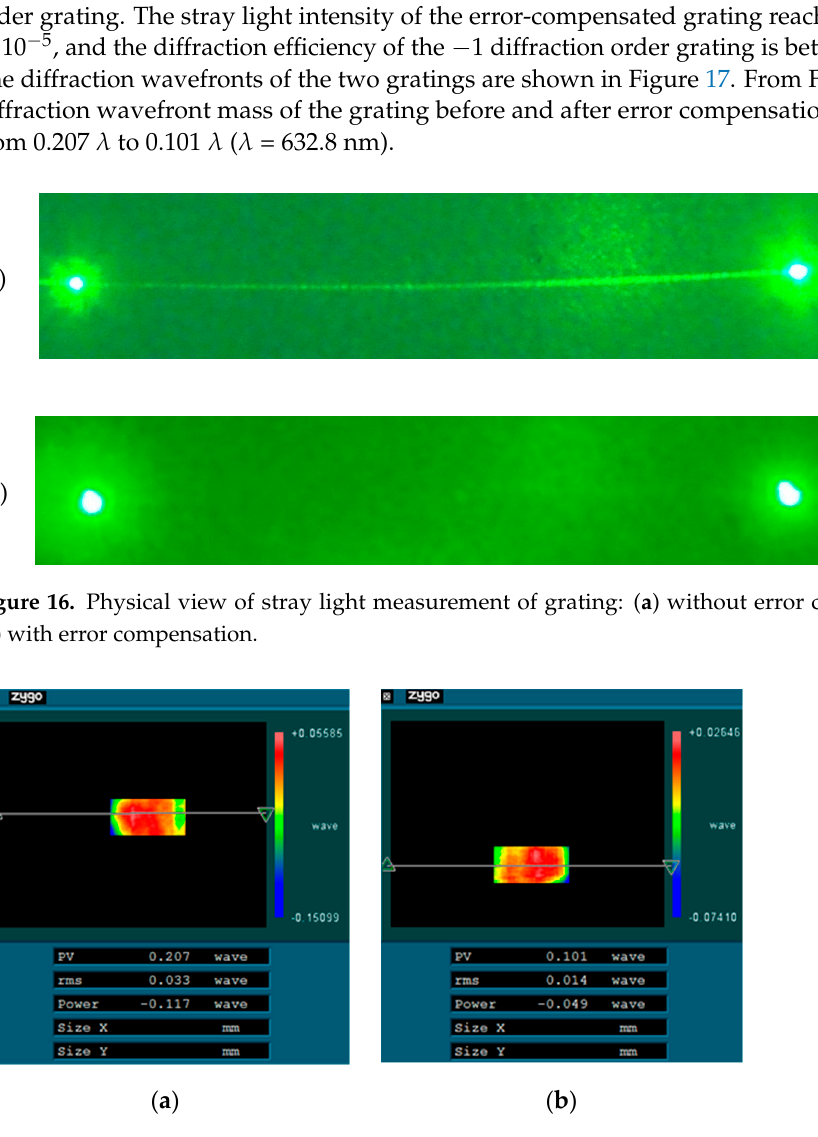
Figure 15. Wavefront comparison of 79 g/mm mid-step grating before and after error compensation: ( a ) no error compensation; ( b ) with error compensation.